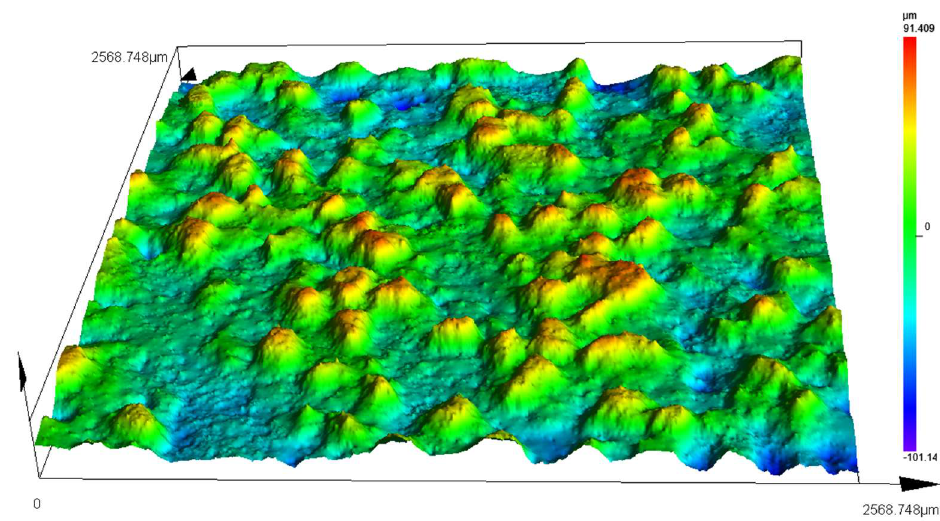
Figure 11. Microtopography of surface abrasive particles of the conductive grinding wheel after dressing.